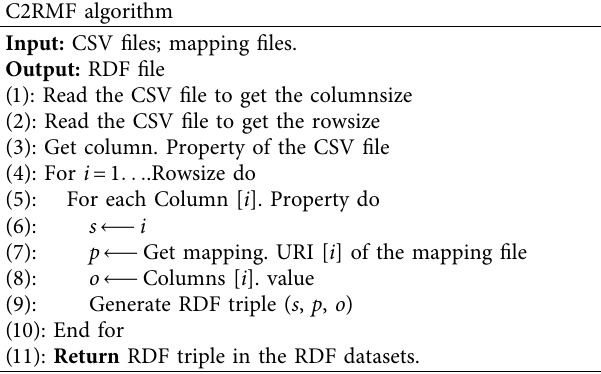
Table 5: C2RMF algorithm. C2RMF